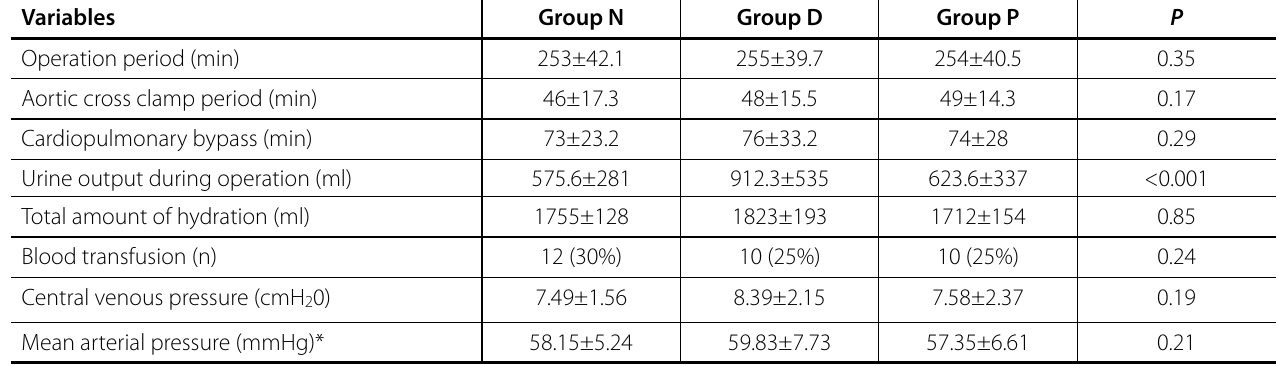
Table 2. Intraoperative